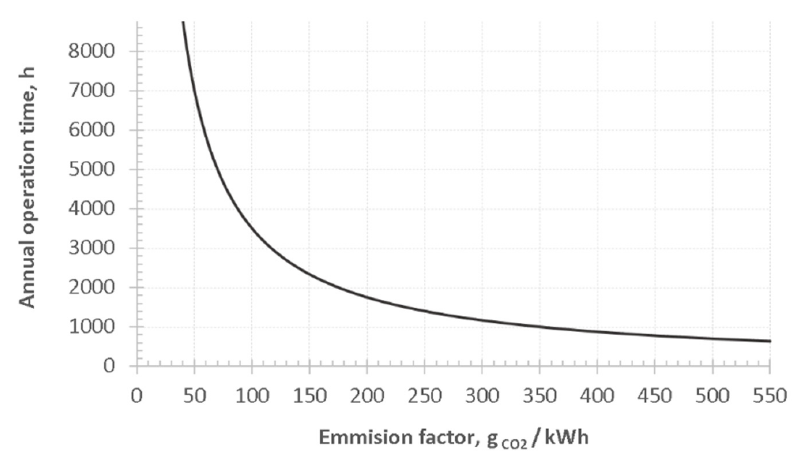
Figure 10. Annual operation time of a power unit taking part in a capacity support mechanism, depending on the emission factor (g CO2 /kWh).